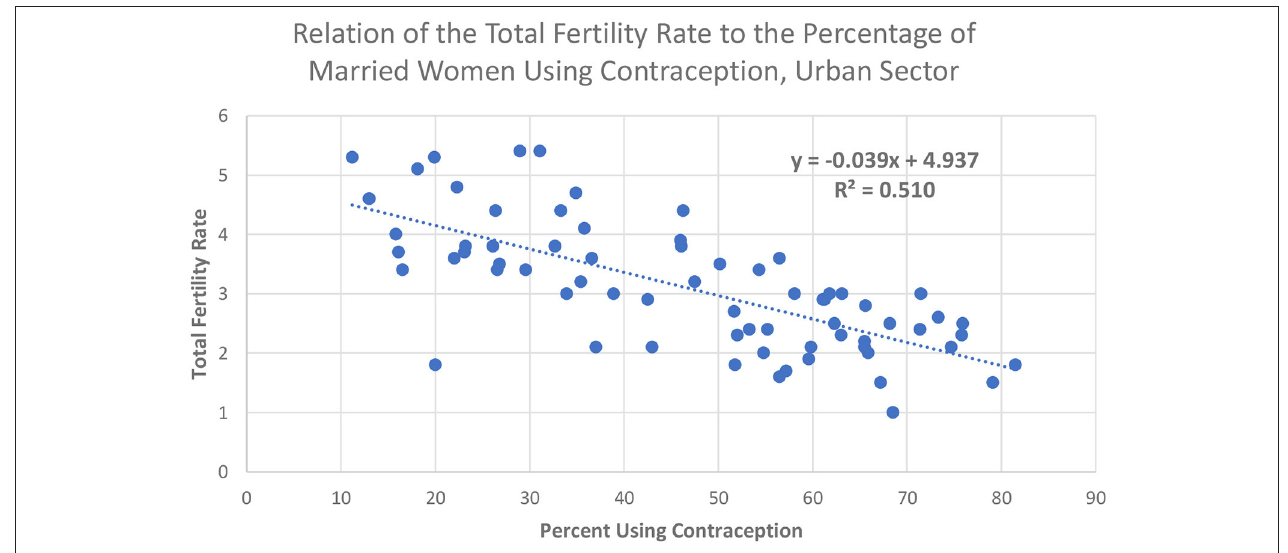
FIGURE 8 | Relation of the Total Fertility Rate to the percentage of married women using contraception, urban sector.